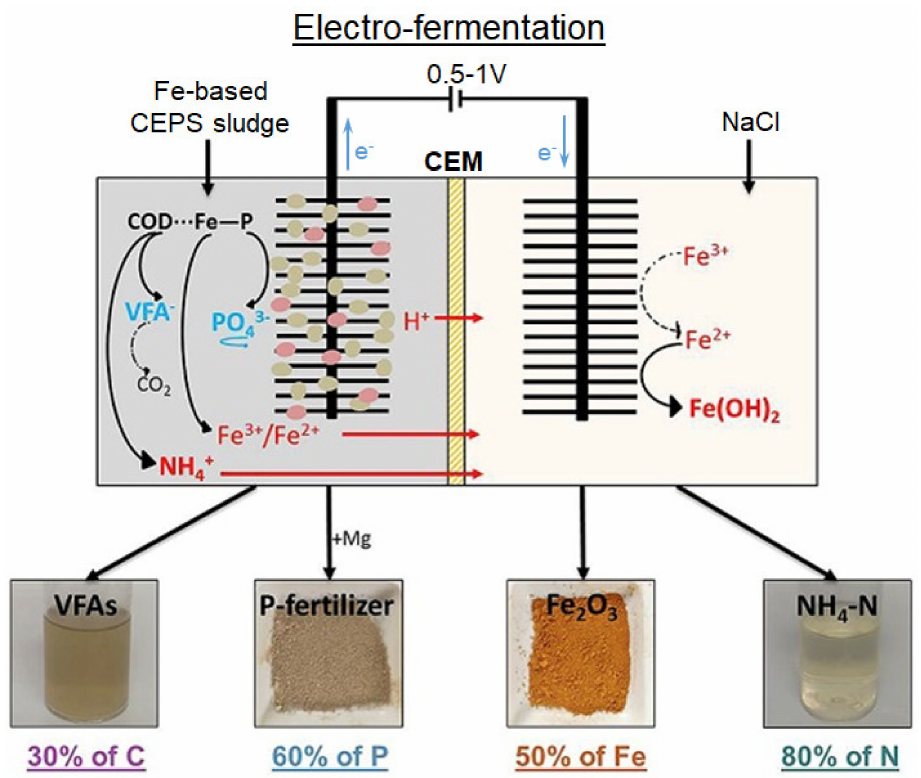
Figure 6. Electrofermentation of sludge that contains P V and iron in organic matter. Reproduced with permission from [119]. Copyright 2022